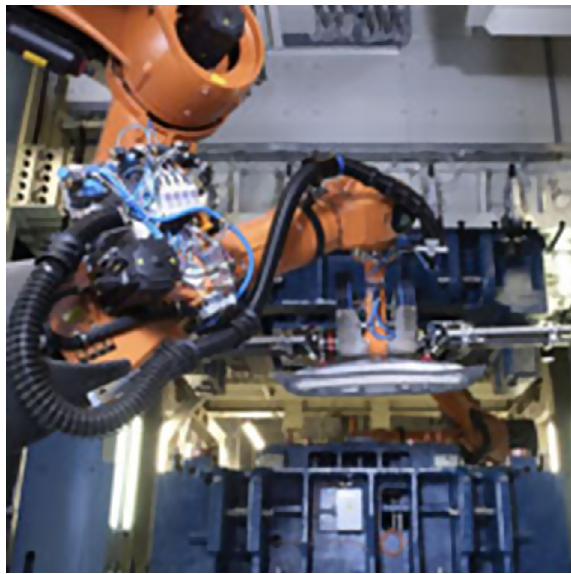
Figure 3. ‘‘Crossbar Robot’’ transfers parts directly from press to press (Schuler Automation) [23].